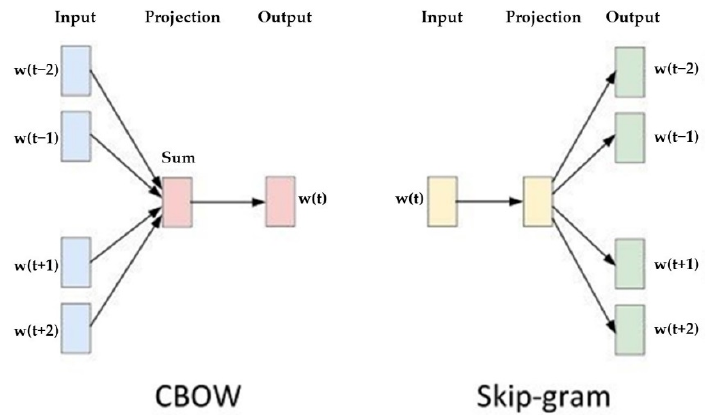
Figure 4. Two most popular frameworks of word2vec: ( left ) CBOW; ( right ) skip-gram [15].